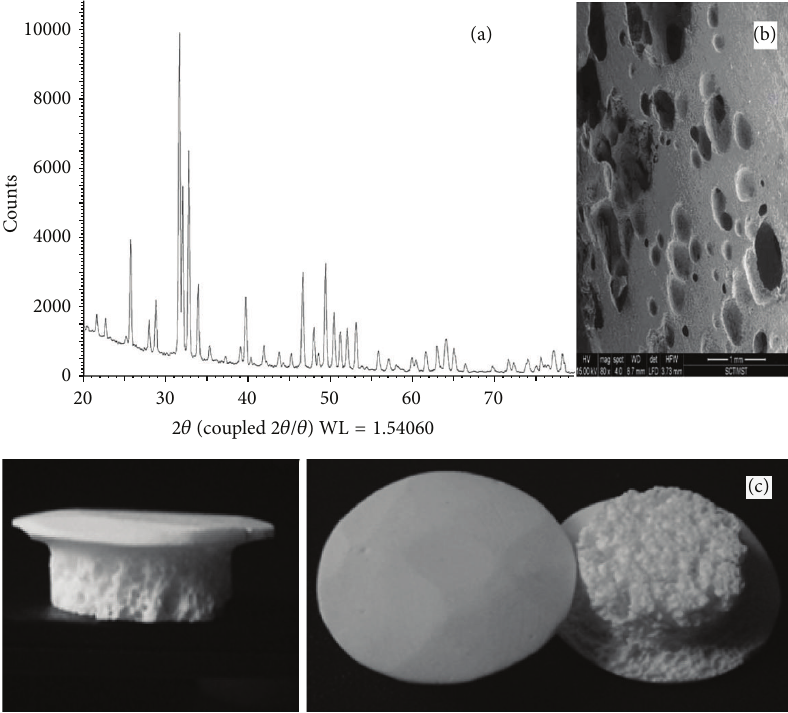
Figure 1: (a) Physicochemical characterization of HA burr hole buttons device using XRD spectrum of the powdered device material with the standard pattern of hydroxyapatite (PDF 9-432) superposed. (b) SEM micrograph of HA Burr Hole Buttons showing porosity distribution. (c) HA-Burr Hole